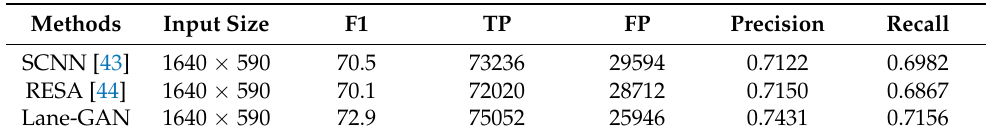
Table 3. The comparison results between the proposed method and the state-of-the-art methods on the simulated blurred CULane dataset.